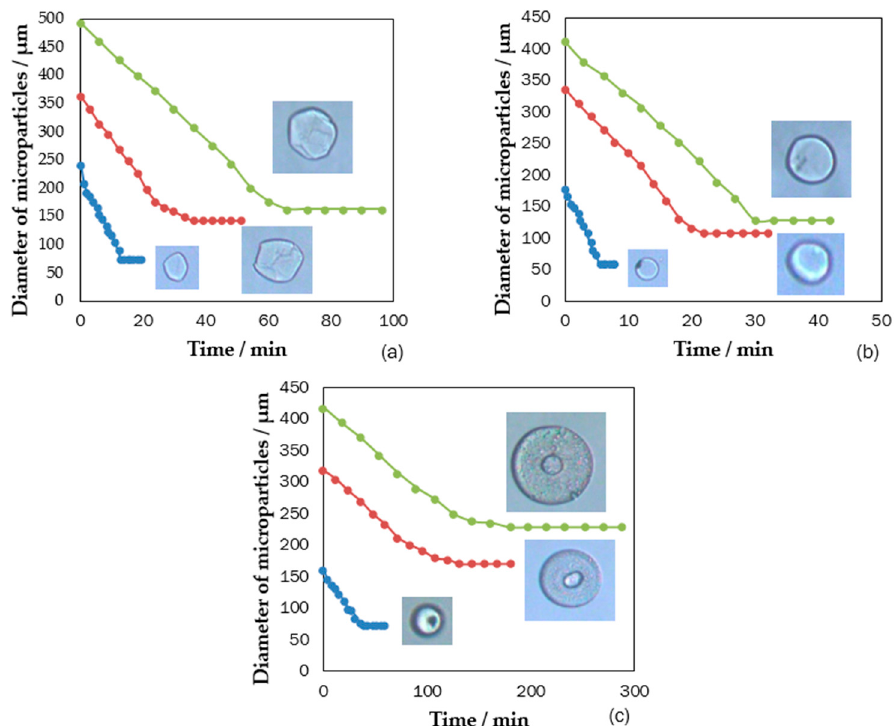
Figure 2. ( a – c ) The relationship between time extraction process required and droplets’ diameter under the condition that extractant was 1-octanol including 20 wt.% octane, 1-octanol including 20 wt.% n-Butanol and n-Butanol separately.